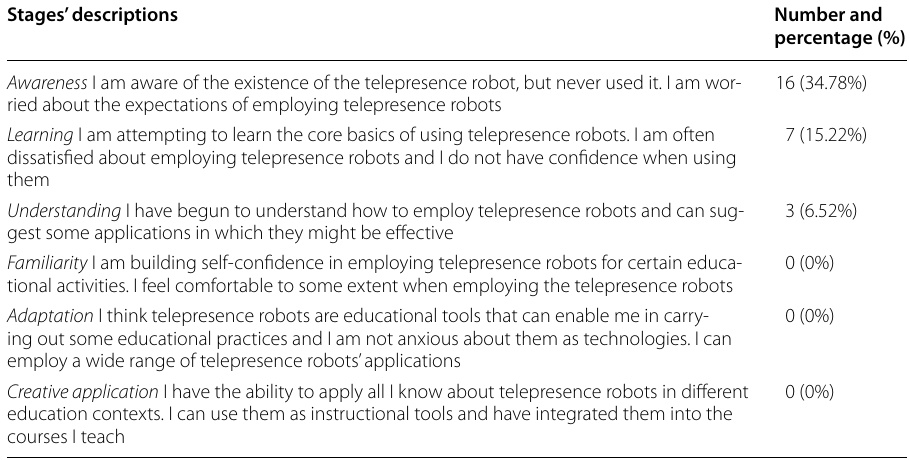
Table 8 Six stages of the process of employing telepresence robots into educational activities Stages’ descriptions Number and